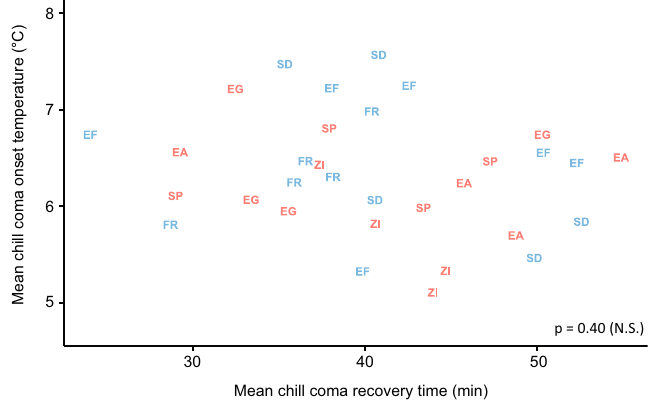
Figure 4. Mean chill coma onset temperatures (CCO) plotted against mean chill coma recovery times (CCRT) of all lines in all populations. Two-letter population codes are used as points to identify the population to which each line belongs: EA Ethiopian lowlands, EF Ethiopian highlands, EG Egypt, FR France, SP South African lowlands, SD South African highlands, ZI Zambia. Colours indicate whether the climate of origin is relatively warm (red) or relatively cold (blue). We found no relationship between mean CCO and mean CCRT in the lines or populations studied.